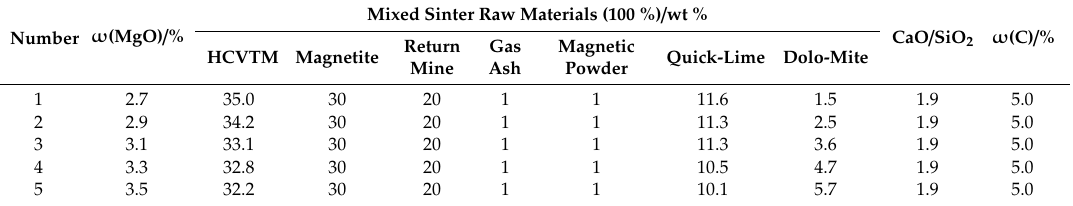
Table 4. Experimental scheme and ingredient of sinter materials.